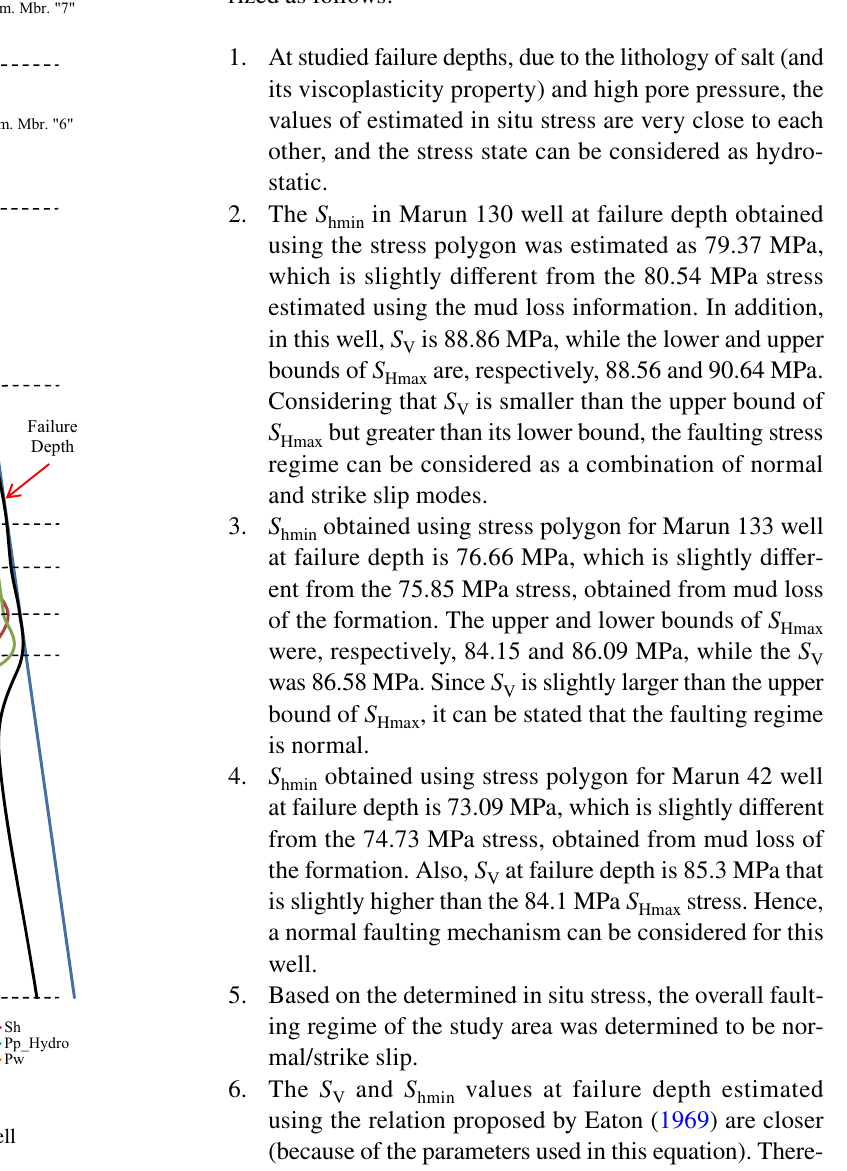
Fig. 7 In situ stress determined for Marun 42 S and S relative to S by the different methods are hmin Hmax V shown with a +/− sign in Table 1.